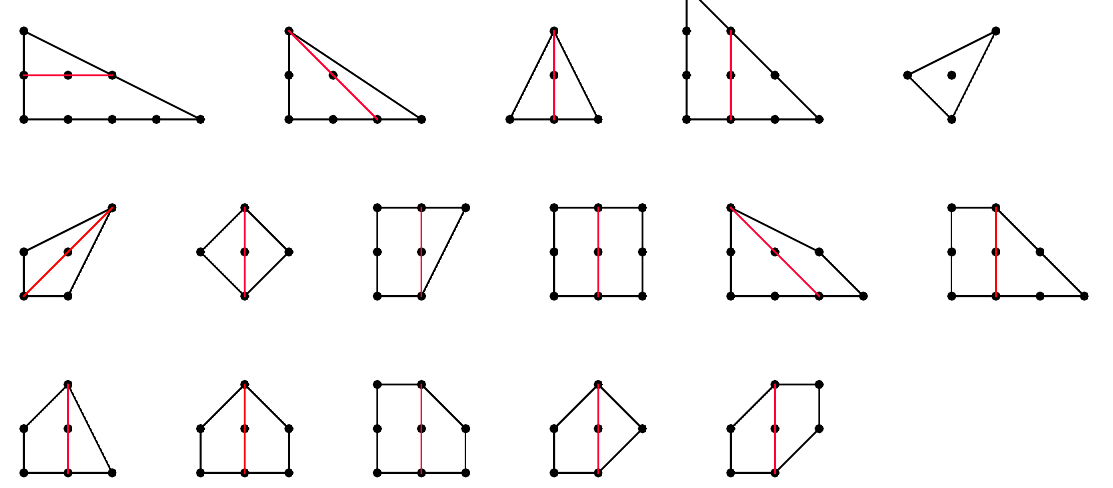
Figure 14 . Toric diagram of rank one theory. The red lines indicate the partial resolution which give a gauge theory